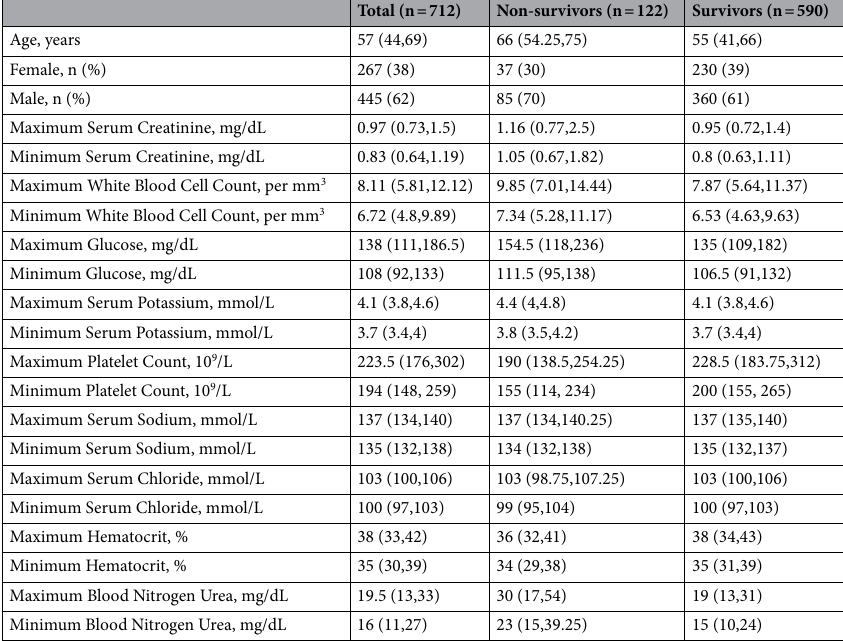
Table 1. Features in the UW dataset stratified by survivors and non-survivors. All variables are median and interquartile range unless otherwise specified.